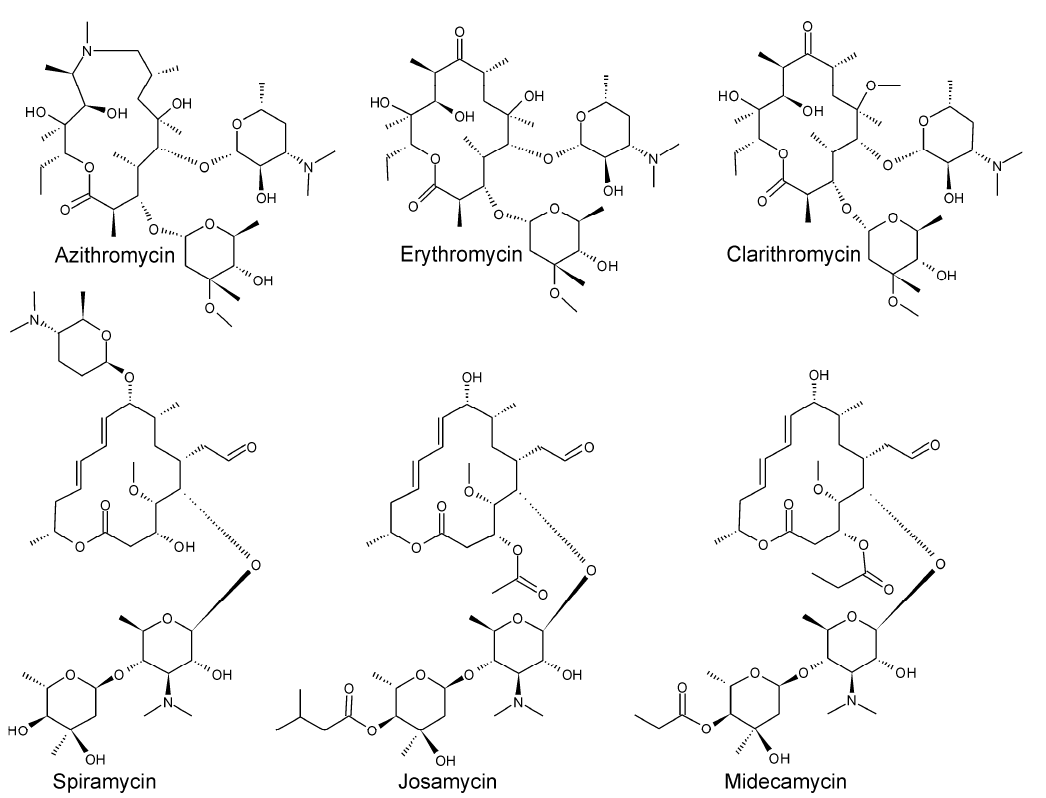
Figure 1. Structural formulas of the studied macrolides.